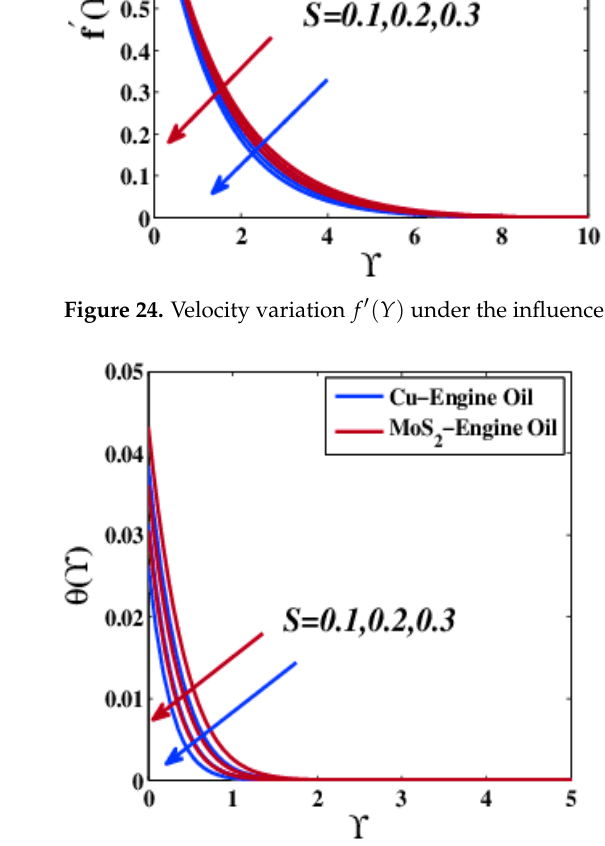
Figure 25. Temperature variation θ ( Y ) under the influence of S > 0.